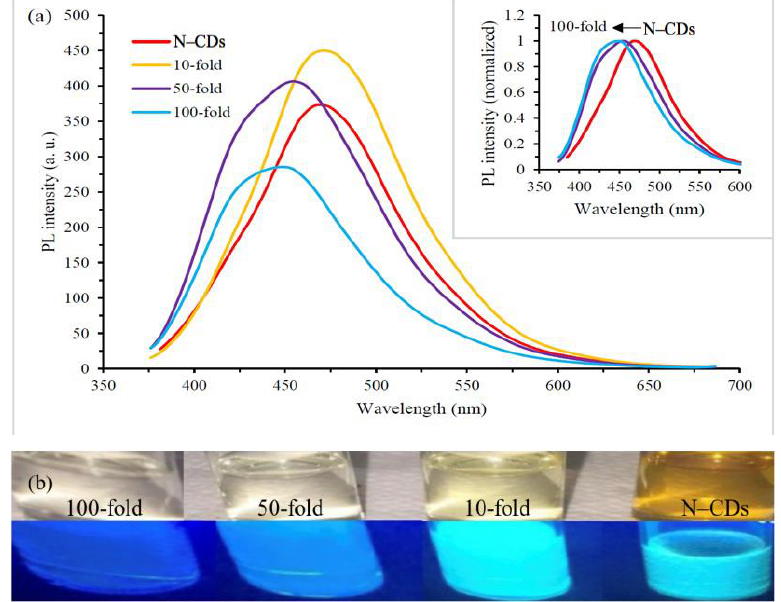
Figure 4. PL spectra of the N–CDs at different dilution factors starting with N–CDs, 10, 50 and 100-fold ( a ) and the corresponding digital images at different dilutions under daylight (above) and UV-light (365 nm) (below) ( b ). Inset shows the normalized fluorescence emission spectra of N–CDs at different dilutions with the excitation wavelength of 350 nm.